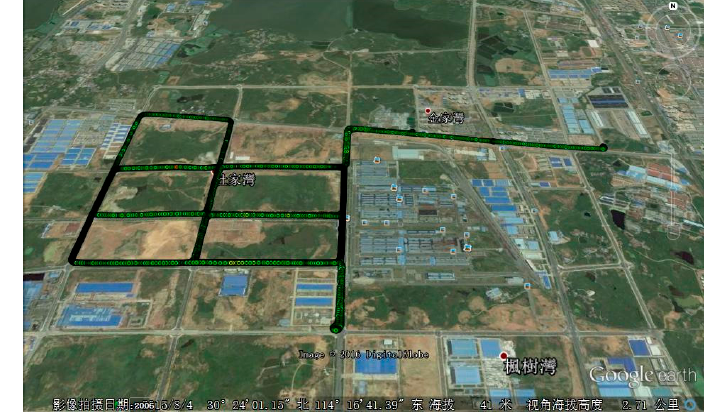
Figure 3. Trajectory of test #1. Sensors 2020 , 20 , x FOR PEER REVIEW